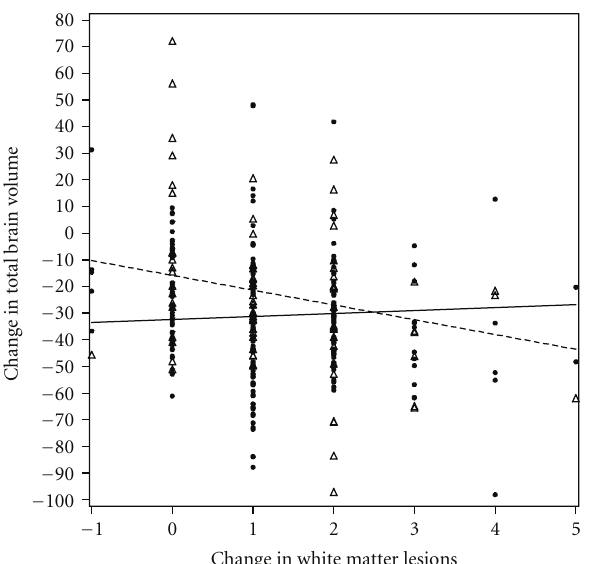
Figure 3: E ff ect modification by APOE genotype on relation of change in WML and change in total brain volume for APOE ε 3/ ε 3 (black dots, solid regression line) and ε 3/ ε 4 plus ε 4/ ε 4 groups (triangles, dashed regression line). The slopes of the two lines were di ff erent ( P < 0.05).